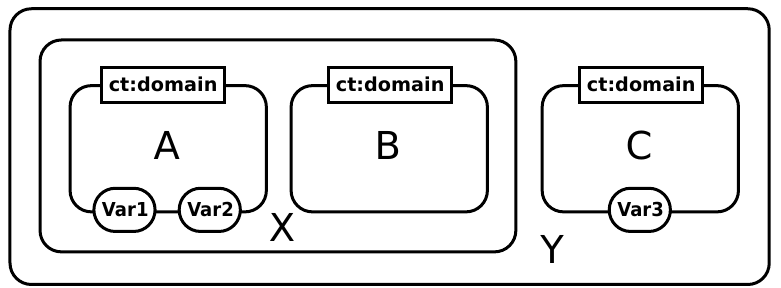
Figure 2.41: The Entity Relationship glyph for domain